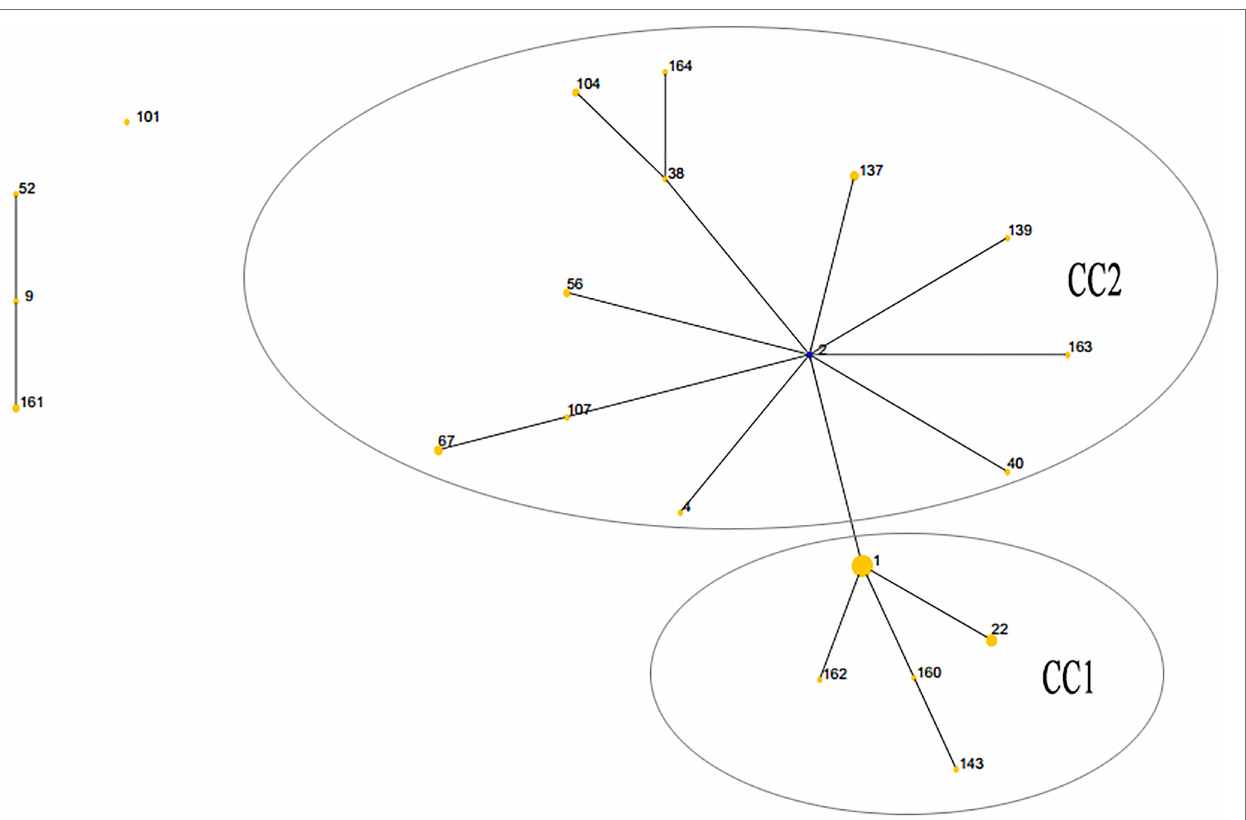
FIGURE 1 | Population structures of 59 Ureaplasma spp. isolates resistant to quinolones and macrolides predicted by eBURST. CC, clonal